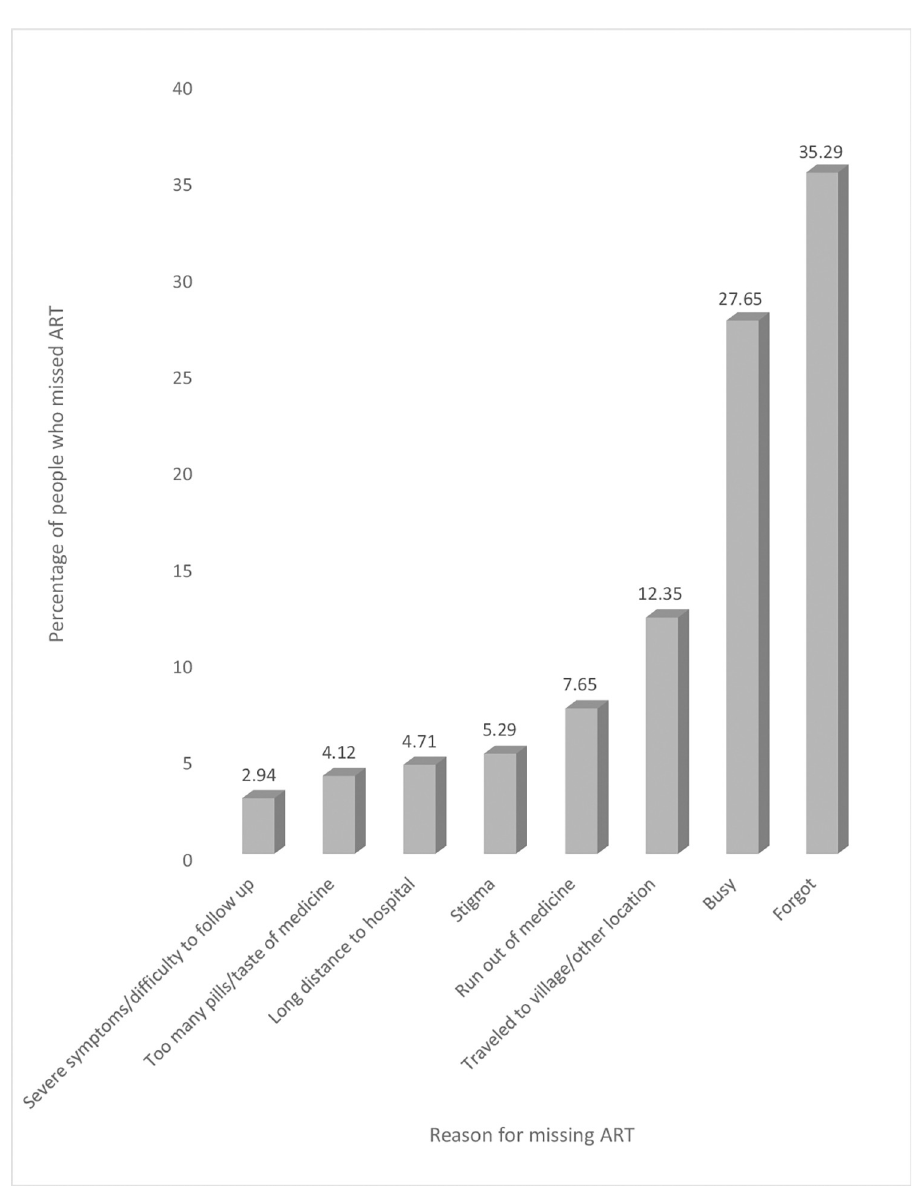
Fig 2. Proportion of patients that missed ART versus reasons ART was